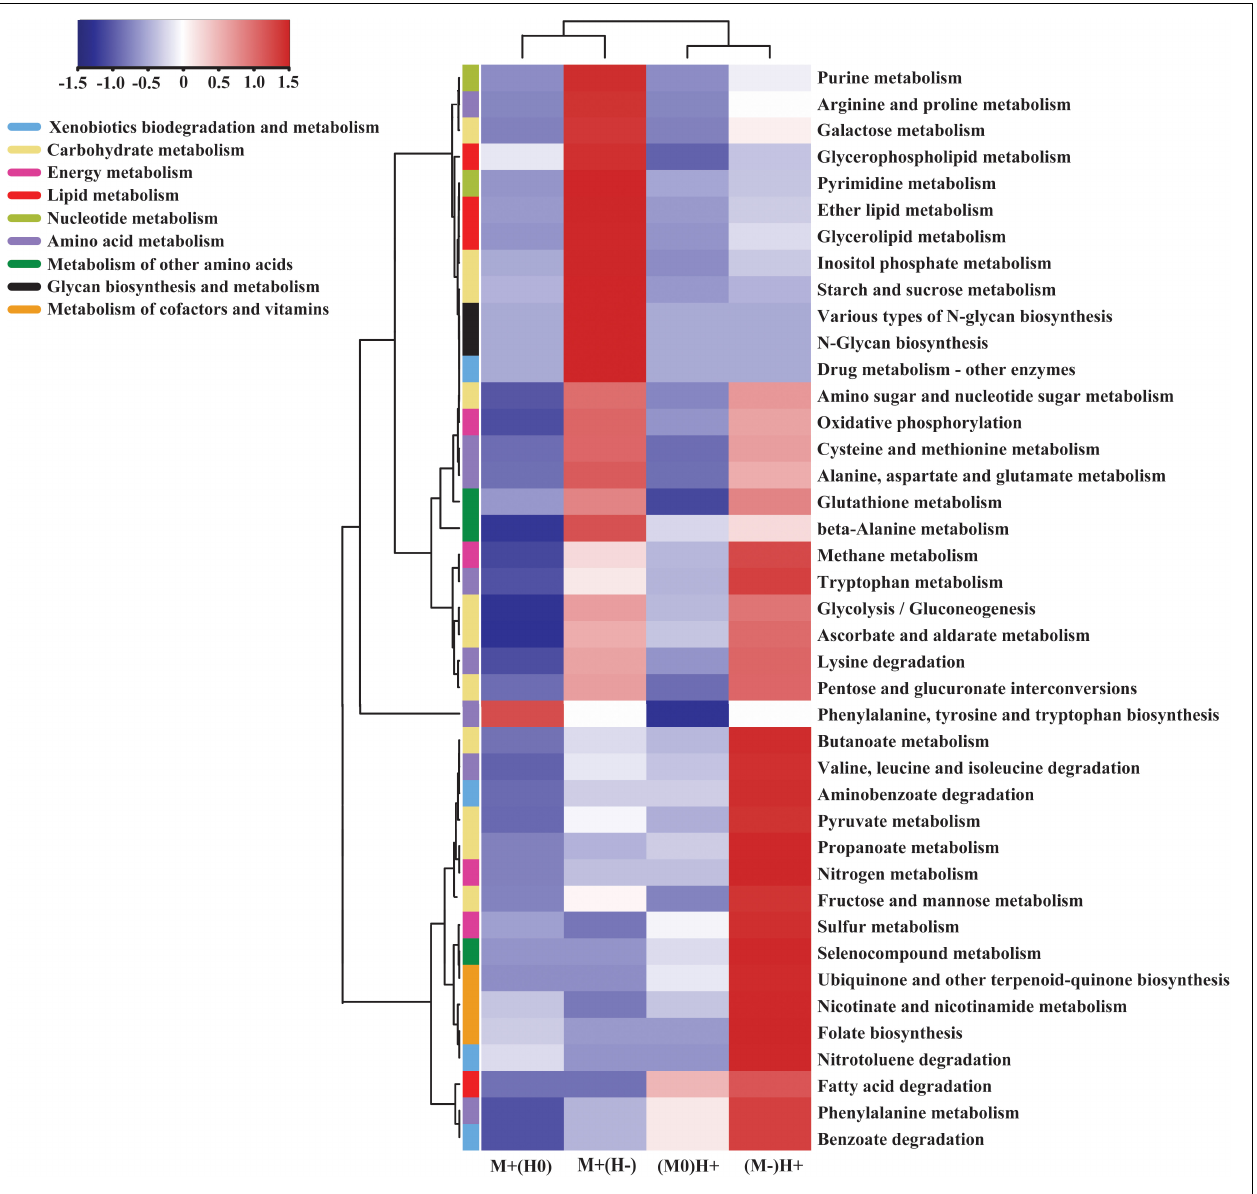
FIGURE 3 | Heatmap comparing the kinds of gene, which has the significantly different abundance across the groups, on the specific KEGG metabolism pathway. M + (H0) indicates that, in this column, the abundance of genes was significantly increased in the MC group compared to the LC group, and meantime, had no significant changes between MC group and HC group; M + (H-) indicates that, in this column, the abundance of genes was significantly increased in the MC group compared to the LC group, and meantime, was significantly decreased in the HC group compared to the MC group; M0(H+) indicates that, in this column, the abundance of gene had no significant changes between LC group and MC group, and meantime, was significantly increased in the HC group compared to the MC group; M-(H +) indicates that, in this column, the abundance of genes was significantly decreased in the MC group compared to the LC group, and meantime, was significantly increased in the HC group compared to the MC